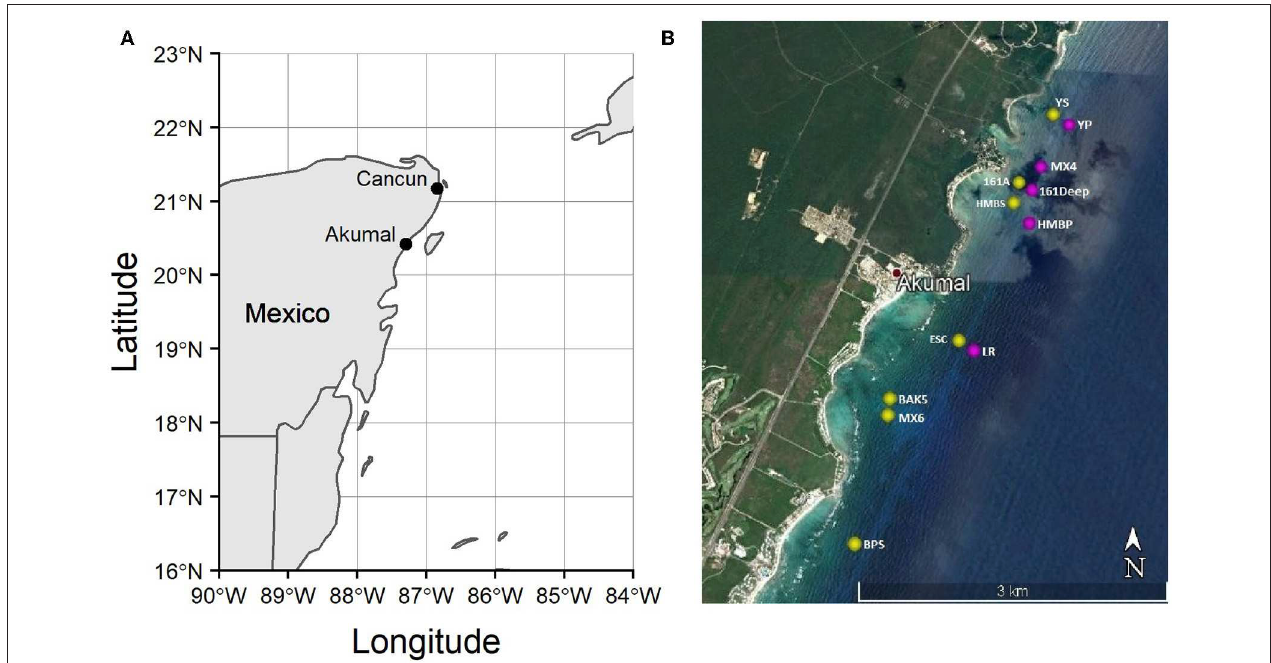
FIGURE 2 | Map of the study region. (A) Location of Akumal, Mexico on the Yucatán Peninsula; (B) Survey site locations on Akumal coral reefs, made with Google Earth. Yellow dots indicate sites on the shallower spur-and-groove set ( ≤ 11m), and pink dots indicate sites on the deeper set of spur-and-grooves (12–17m).